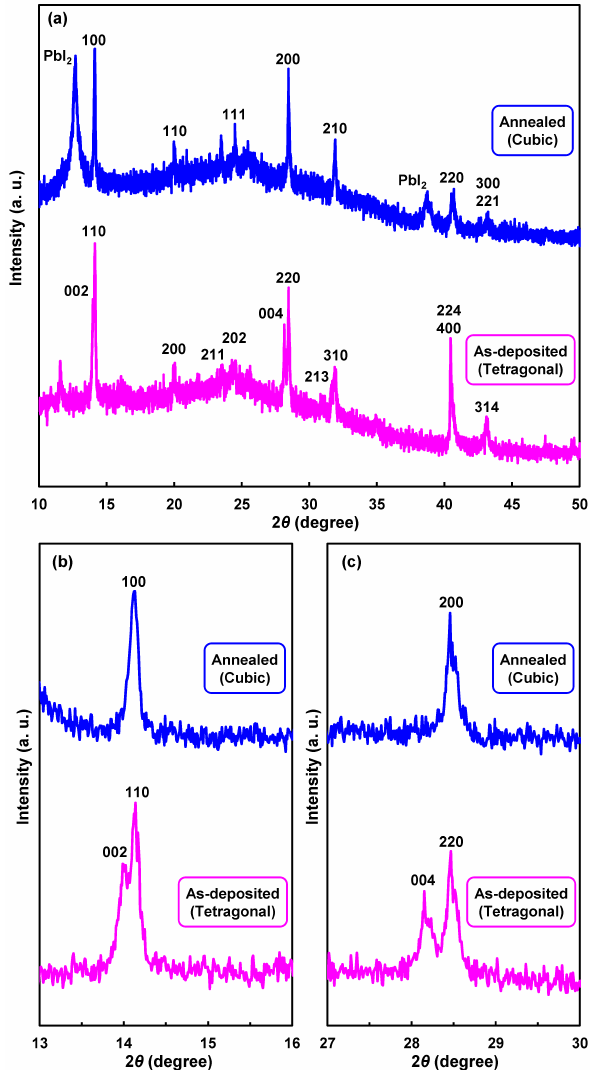
Figure 2: (a) XRD patterns of CH 3 NH 3 PbI 3 thin films before and after annealing. Enlarged XRD patterns at a 2 θ of (b) ~14 ∘ and (c) ~28 ∘ . Copyright (2014) The Japan Society of Applied